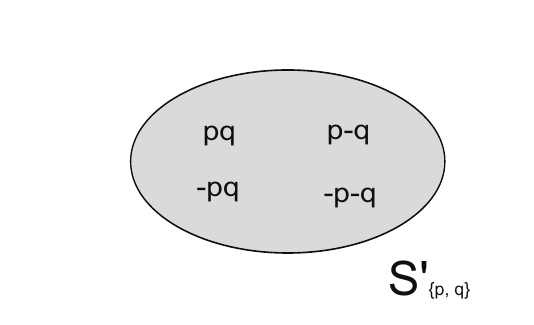
Figure 1. An objective state space.